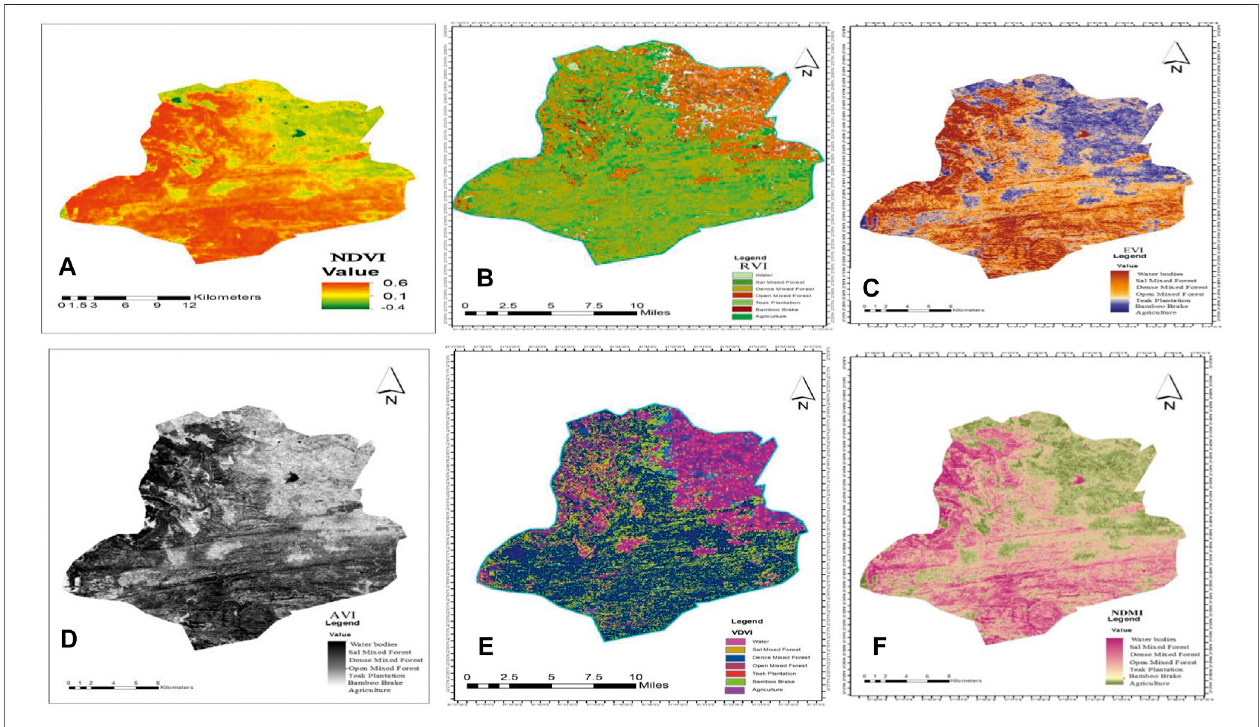
FIGURE5| Spectralvegetationindices (A) Normalizeddifferencevegetationindex(NDVI); (B) Ratiovegetationindex(RVI); (C) Enhancevegetationindex(EVI); (D) Advance vegetation index (AVI); (E) Very dense vegetation index (VDVI); (F) Normalized difference moisture index (NDMI).